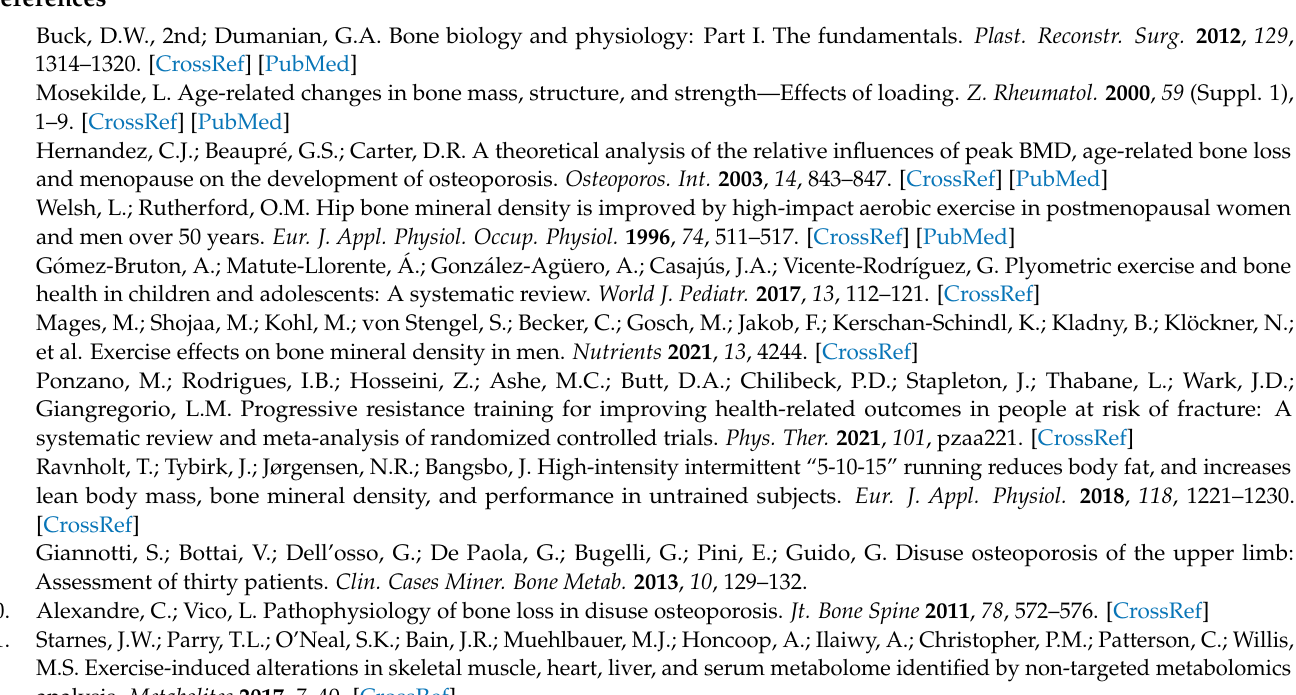
Table S3: Parameters for evaluation of the partial least squares discriminant analysis (PLS-DA) quality of bone samples; Table S4: Detailed information on differential metabolites in the ESI+ mode and ESI − modes; Table S5: Metabolic pathway of differential metabolites in this study; Table S6: Statistics of the transcriptome sequencing data in this study; Table S7: Detailed information on the 9335 differentially expressed genes identified in this study; Table S8: Bone-related differentially expressed genes between the control group and the exercise